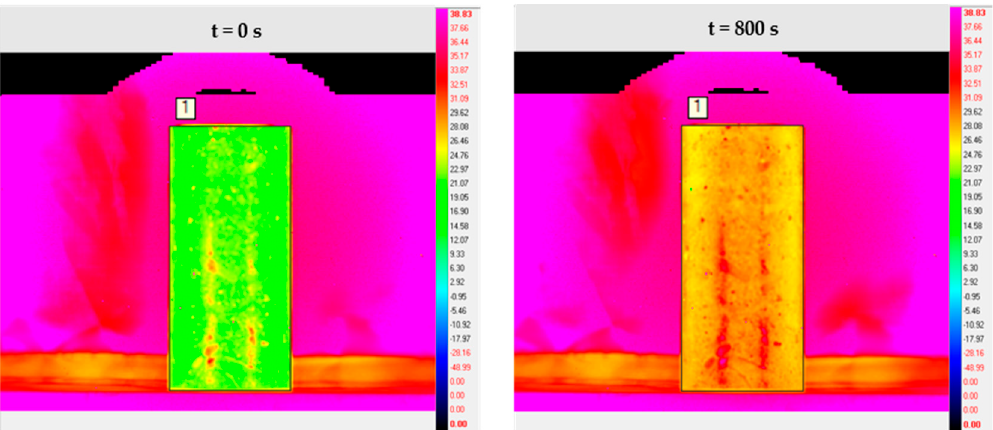
Figure 5. Infrared thermal image of the concrete surface before silane spraying.